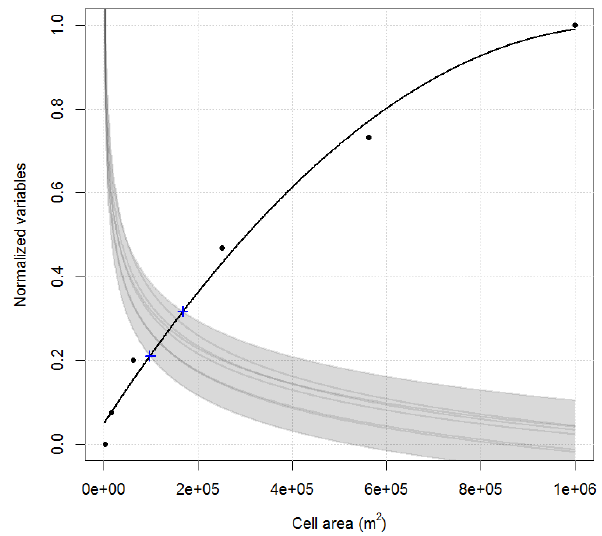
Figure 14. Regression models fitted to the normalized CV(RMSD) of the eight height classes (grey curves) and estimation errors of affected building areas (black